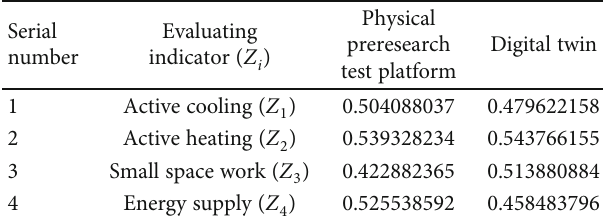
Table 5: Z matrix of the conversion index